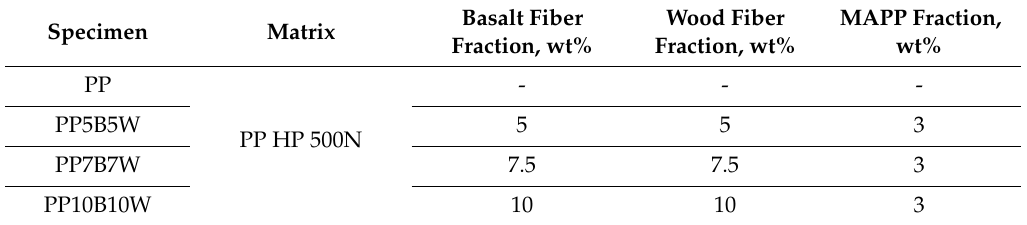
Table 1. Composition of tested materials. MAPP: maleic anhydride-grafted polypropylene. Basalt Specimen Matrix